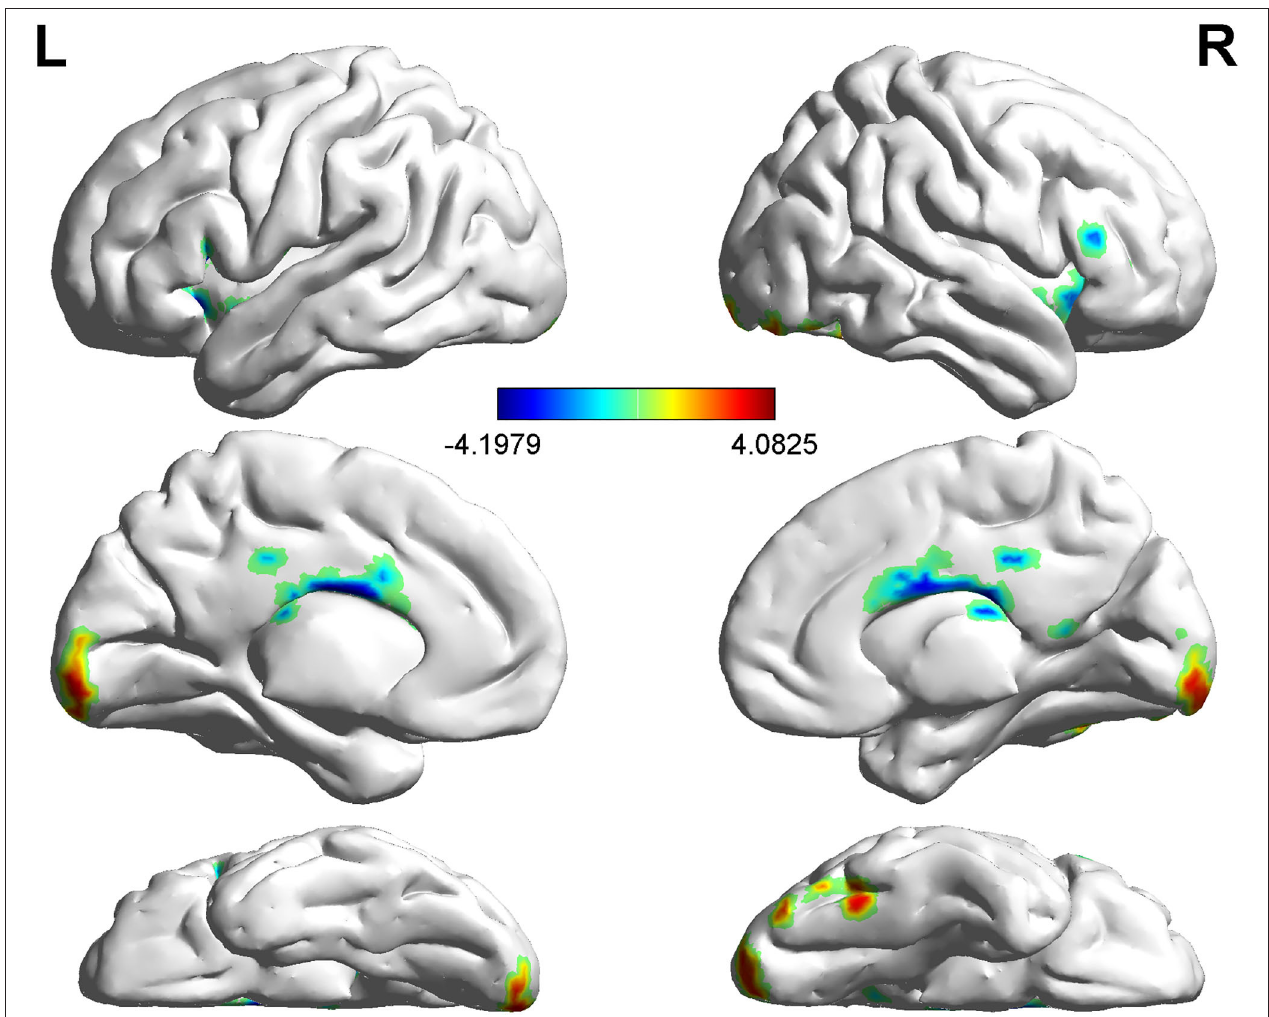
FIGURE 1 | Comparison of amplitude of low-frequency fluctuation (ALFF) between two groups. The figure showed increased ALFF in left-behind children (LBC) in the right LING and decreased ALFF in the bilateral insula and right ORBmid (two-tailed voxel-level p < 0.0 1 and cluster-level p < 0.05, GRF correction). LING, lingual gyrus; ORBmid: orbital part of middle frontal gyrus; GRF, Gaussian Random Field.